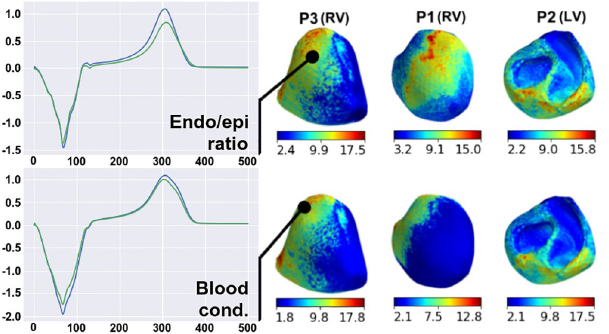
Fig 11. Examples of regional RED maps for the extracellular potential under variation in the epi-endo heterogeneity coefficient (upper panels) and blood conductivity (lower panels). The figure design is the same as in Fig 10.